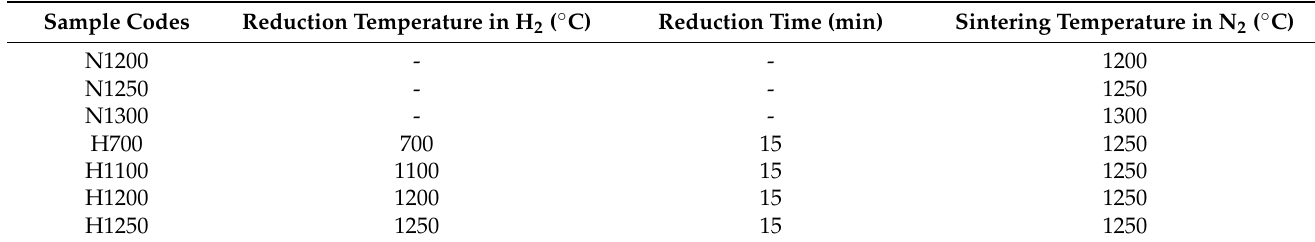
Table 2. Sample codes and corresponding processing parameters (the sintering time is 2 h). Sample